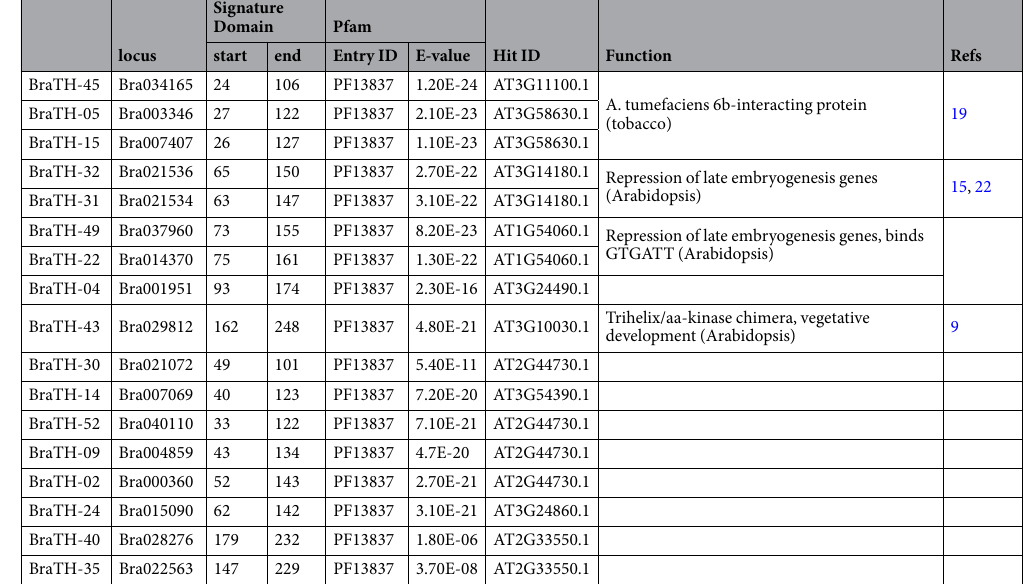
Table 1. The information of trihelix genes in B. rapa and known functions of Arabidopsis trihelix proteins (and those of related genes in other